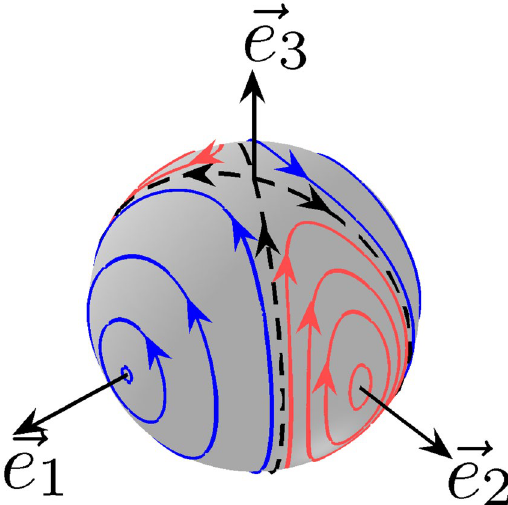
   e e e ( , , ) 1 2 3 . The blue (dark gray) and